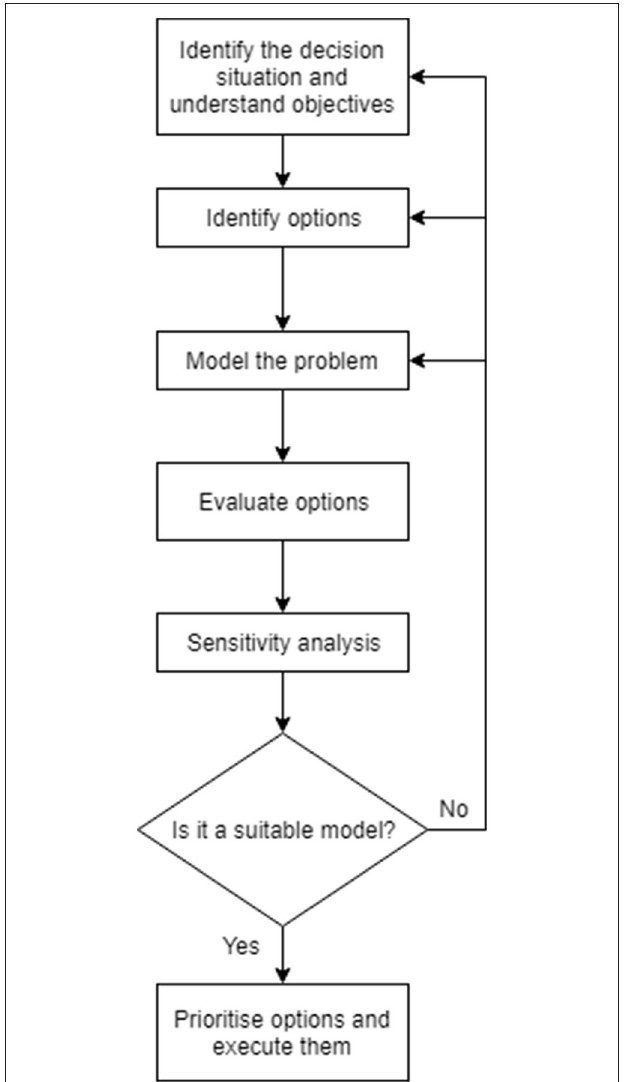
FIGURE 1 | Decision analysis process (adapted from: Clemen and Reilly, 2001